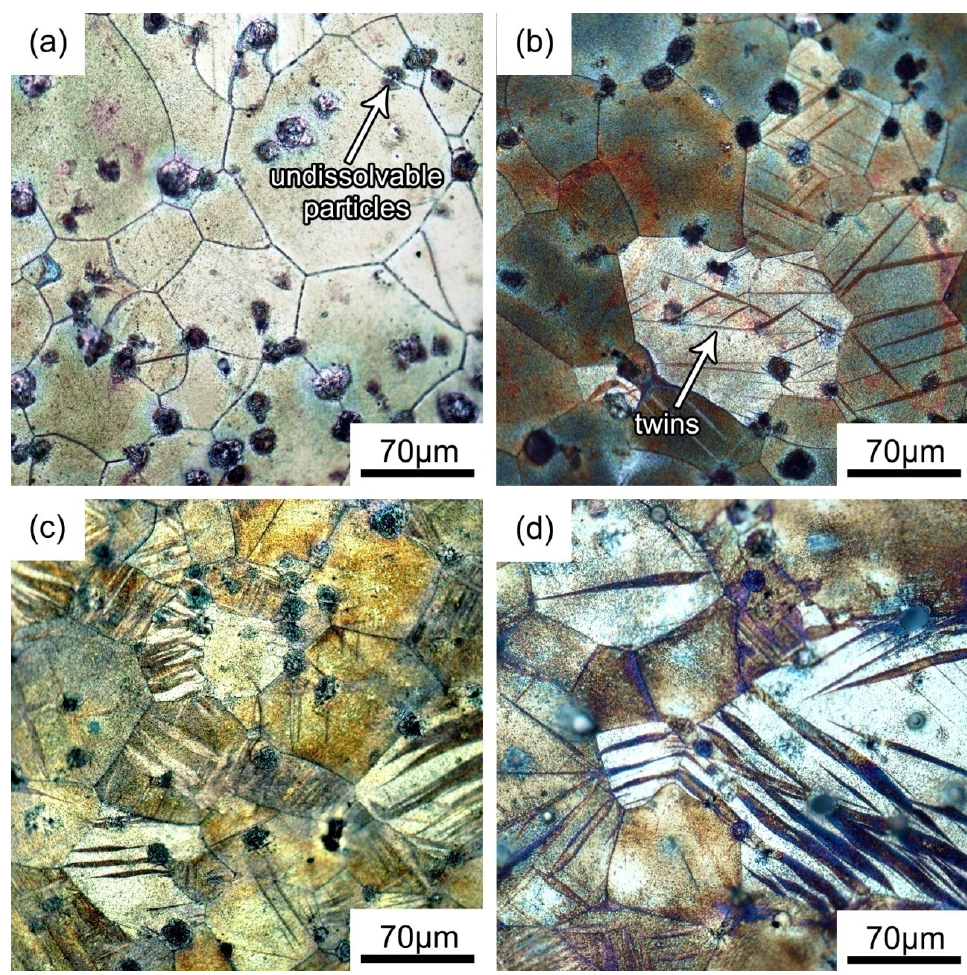
Figure 3. Optical images of quenched specimens with ( a ) 0%, ( b ) 2%, ( c ) 8%, and ( d ) 10% pre-stretching.